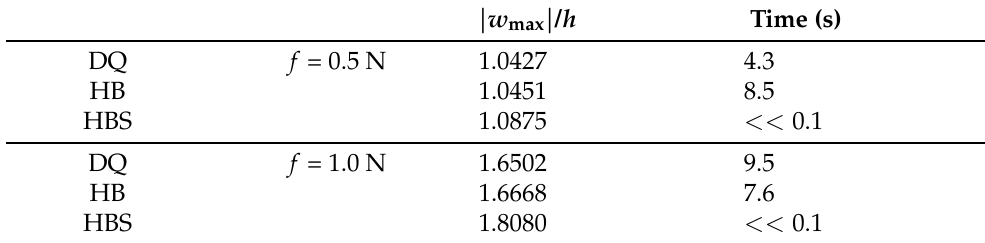
Table 5. Comparison between different